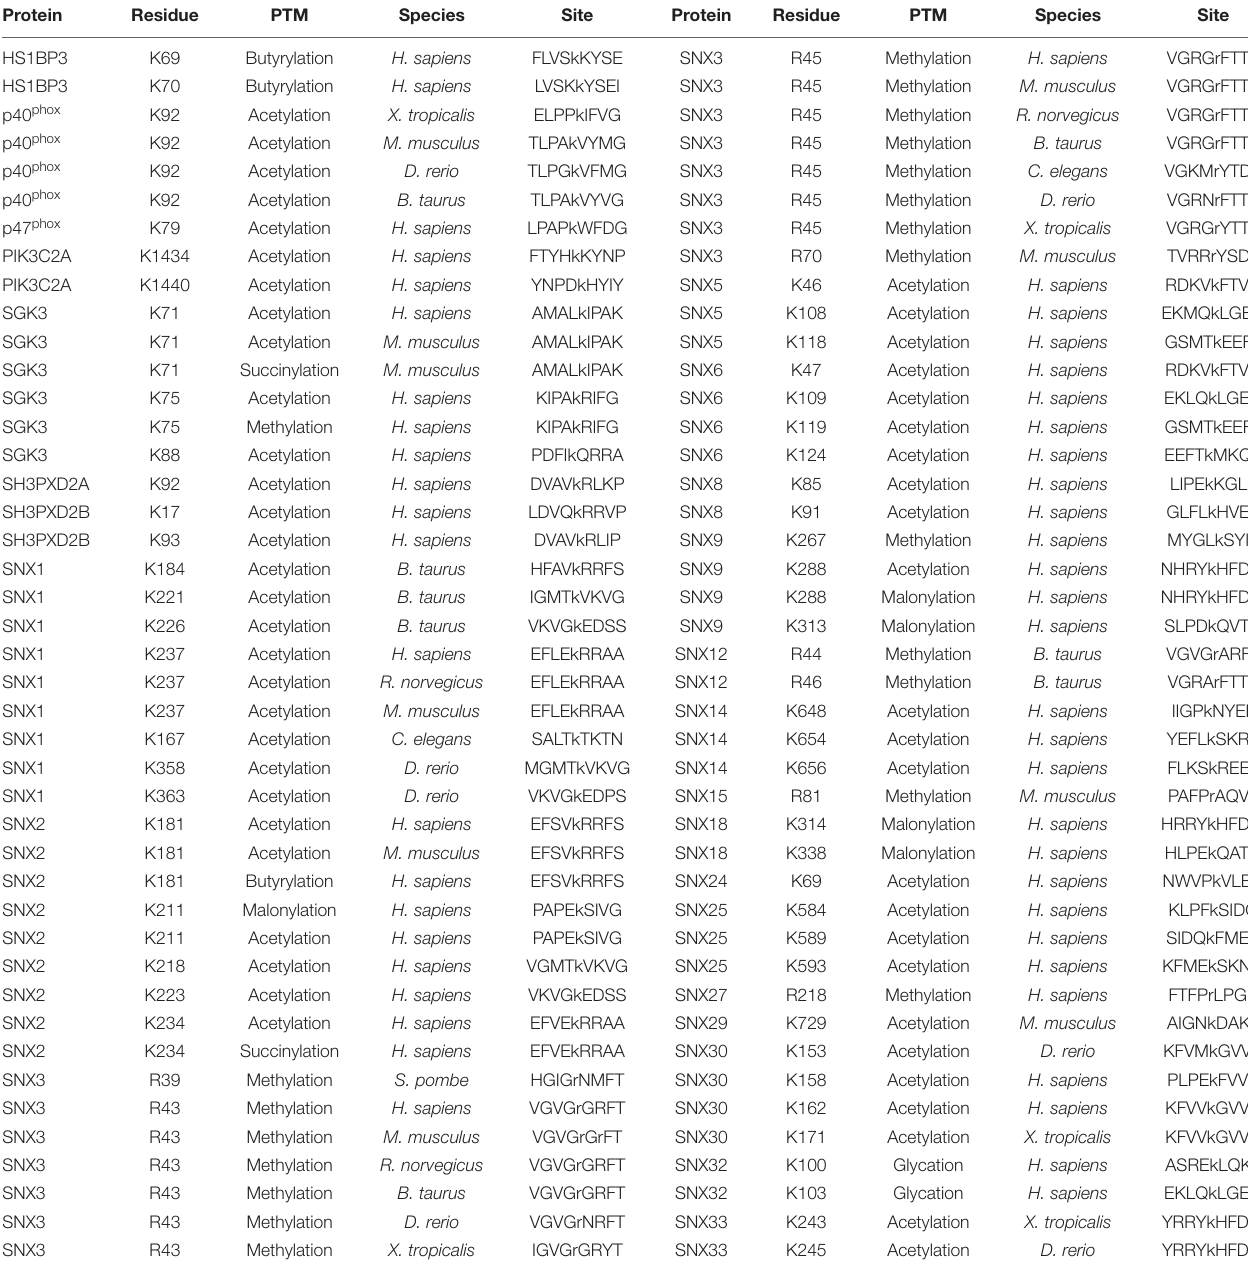
TABLE 2 | PX domains contain diverse metabolite-based post-translational modifications. Protein